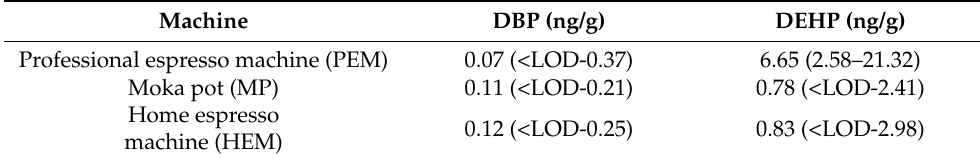
Table 2. Concentrations (median, ng/g) of DBP and DEHP in coffee beverages obtained using different coffee machines: Professional espresso machine (PEM), Moka pot (MP), Home espresso machine (HEM). Machine DBP (ng/g) DEHP (ng/g) Professional espresso machine (PEM) 0.07 (<LOD-0.37) 6.65 (2.58–21.32) Moka pot (MP) Home espresso 0.12 (<LOD-0.25) 0.83 machine (HEM)